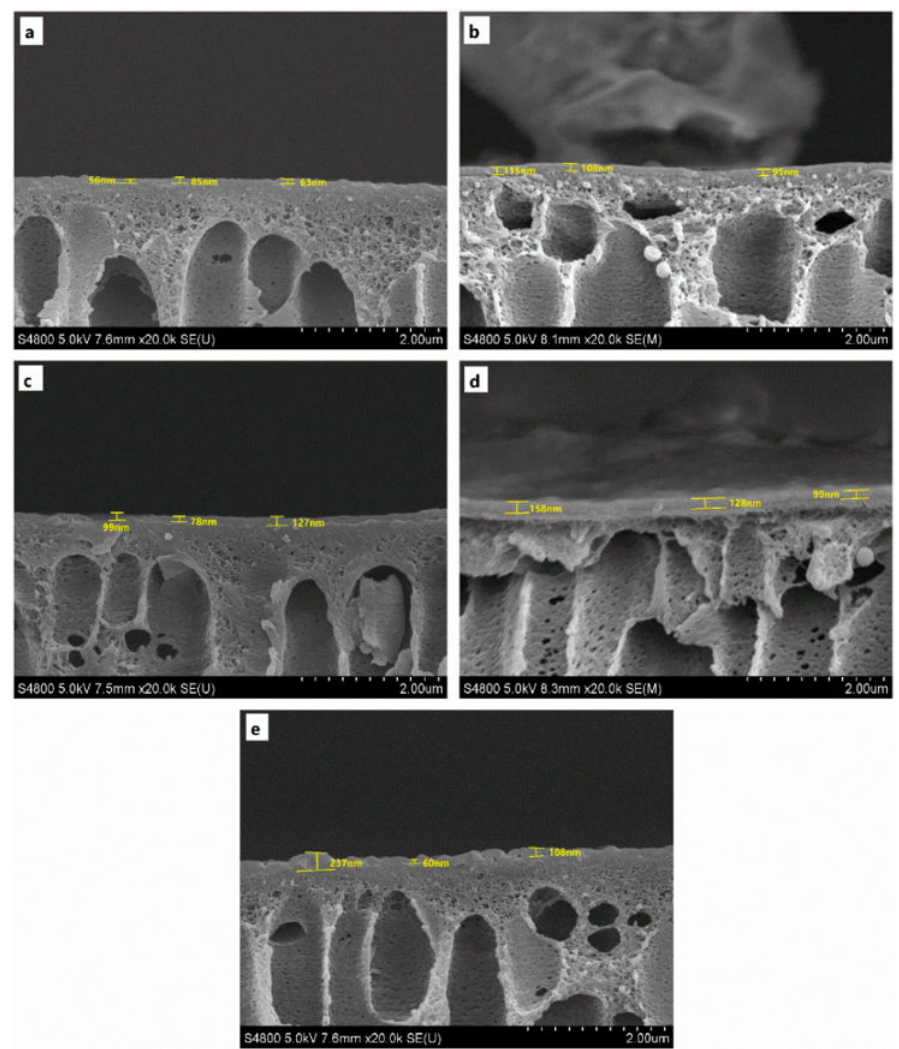
Figure 2. SEM pictures of the cross section for ( a ) PSf/PA and PSf/PA-SiO 2 composite membrane with the mass fraction of SiO 2 of ( b ) 0.0125 wt %; ( c ) 0.025 wt %; ( d ) 0.05 wt %; ( e ) 0.075 wt % in the magnification of 20,000